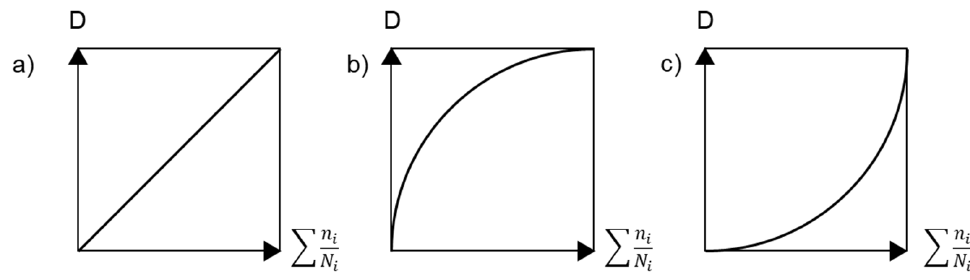
Figure 13. Damage accumulation types: ( a ) linear, ( b ) hyperlinear, ( c ) hypolinear.